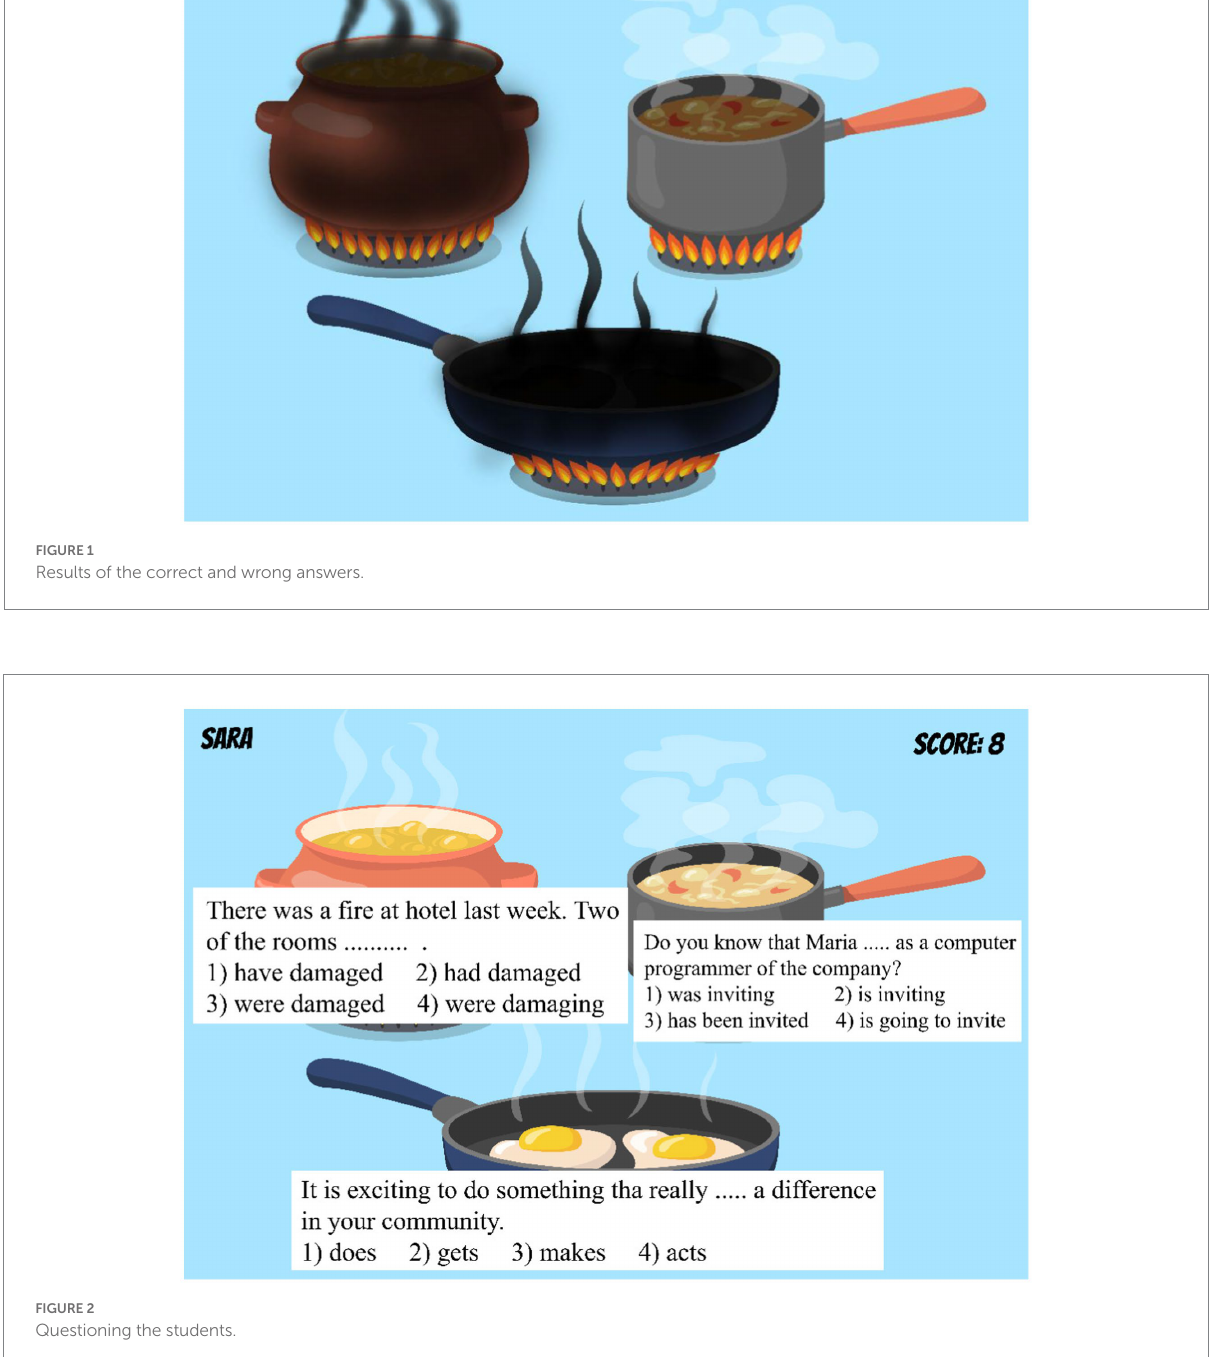
FIGURE 2 Questioning the